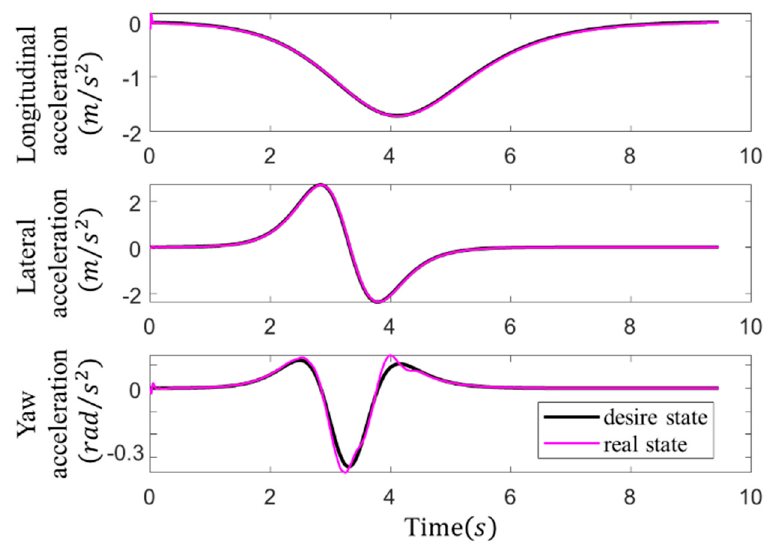
Figure 6. The vehicle dynamic states tracking results in scenario 1.